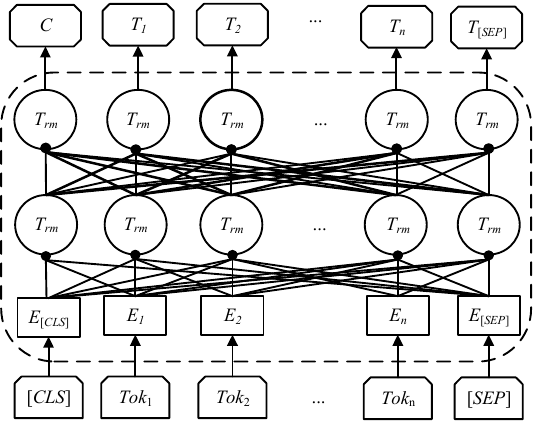
Figure 2. ALBERT